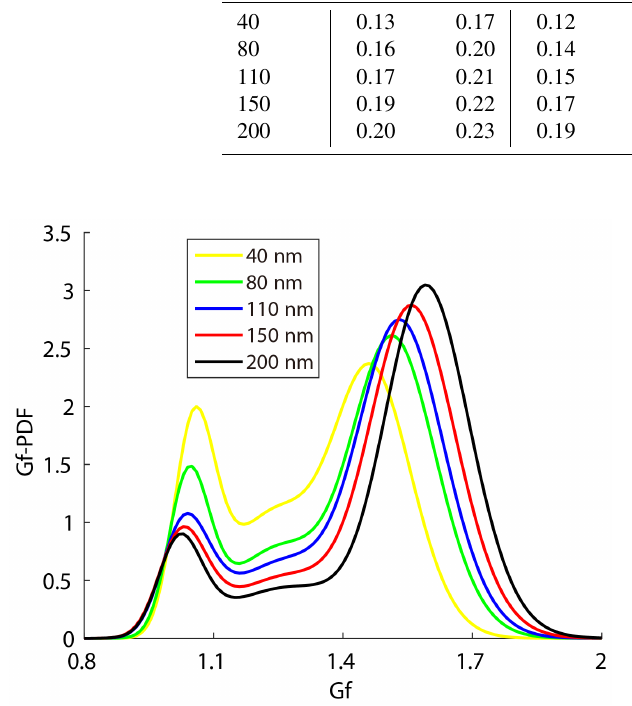
Figure 6. The relationship between size-resolved mass fraction of organics and D 50 at three supersaturations. The red, blue, and green dots and line represent 0.1%, 0.2%, and 0.4% SSs,